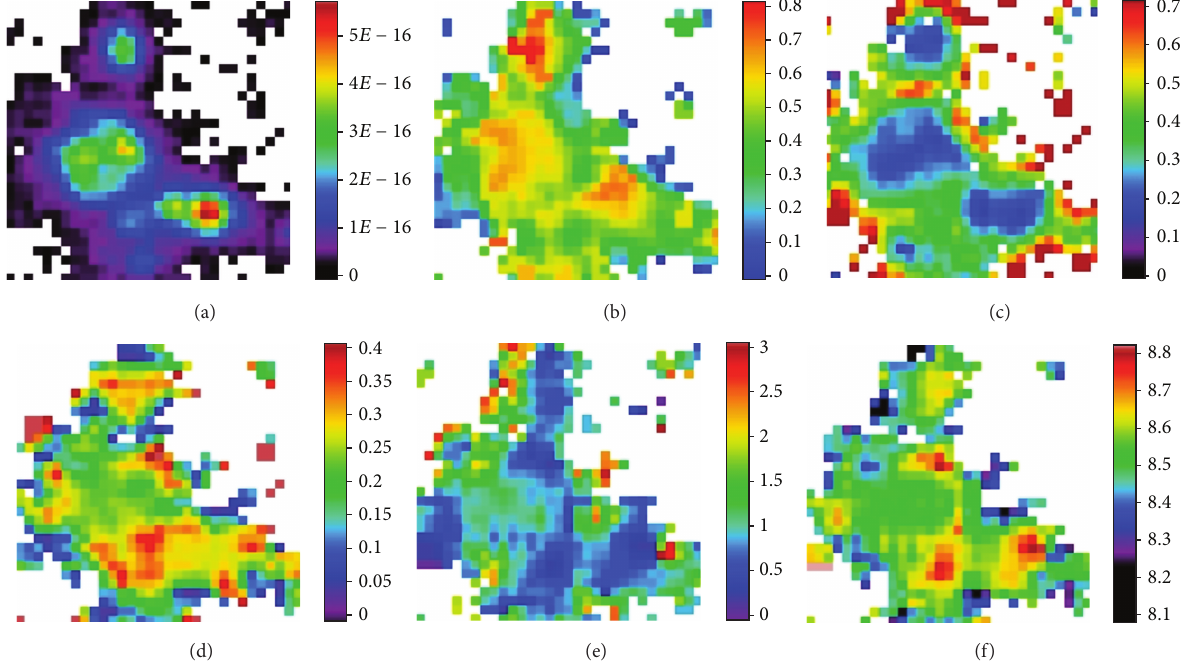
Figure 8: Images centered on HII regions located around RA = 1h36 m46.5 s, DEC = 15d 48m 56.8 s. Top left: H 𝛼 maximum intensity [ergs −1 cm −2 ],topcenter: 𝐸(𝐵−𝑉) ,topright:[SII] 𝜆𝜆 6717+6731/H 𝛼 ,bottomleft:[NII] 𝜆 6584/H 𝛼 ,bottomcenter:[OIII] 𝜆 5007/H 𝛽 ,andbottom right: O3N2 indicator from PP04. FOV is 33 󸀠󸀠 × 33 󸀠󸀠 , North at the top, East to the